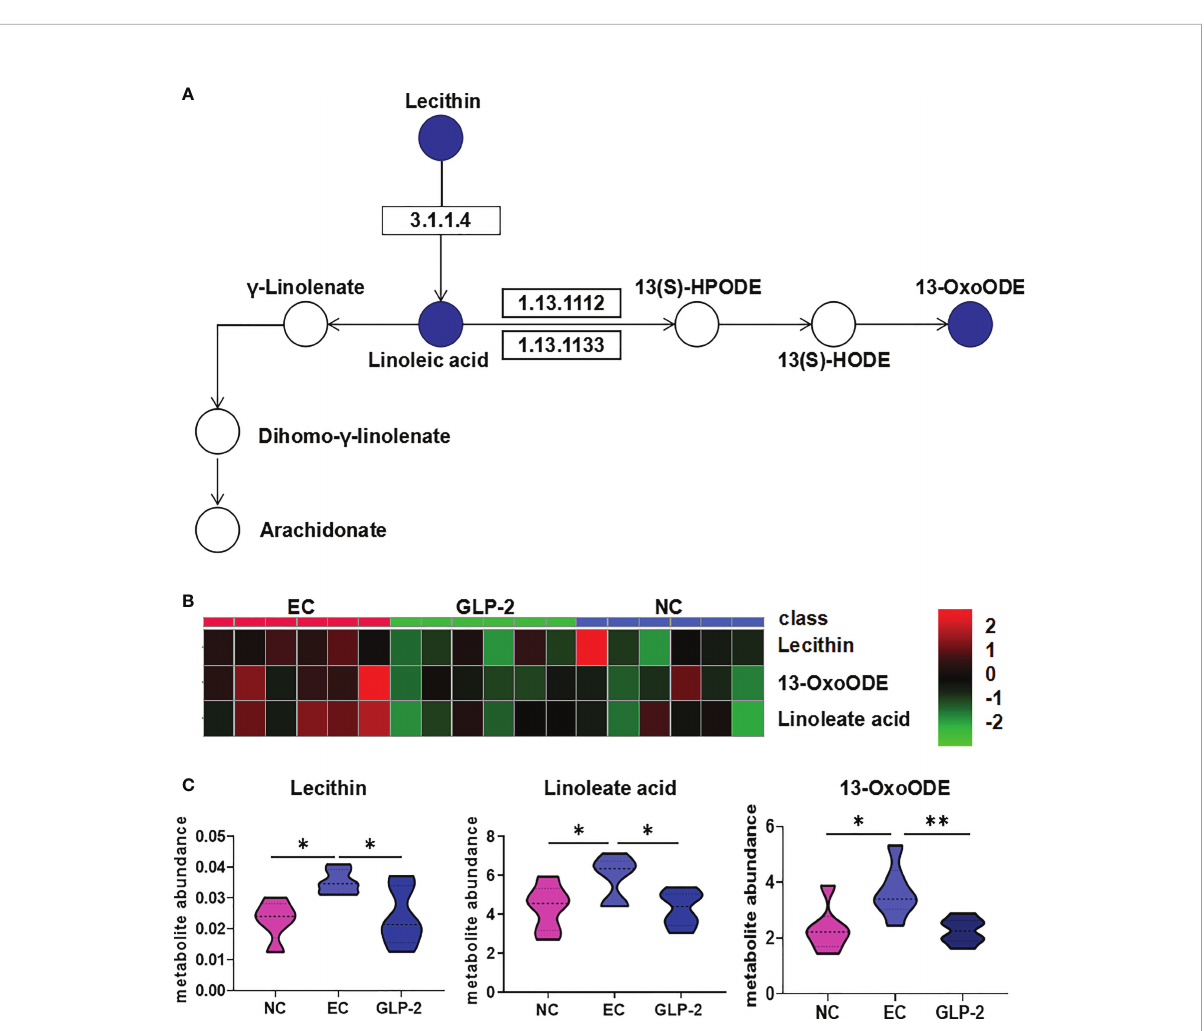
FIGURE 6 Change in linoleic acid metabolism pathway. (A) Differential metabolites of the linoleic acid metabolism pathway in the NC, EC, and GLP-2 groups. The blue circle indicates the differential metabolites. (B, C) the relative abundances of the main metabolites in the linoleic acid metabolism pathway in the NC, EC, and GLP-2 groups based on metabolomic analyses are displayed in the heat map (B) and violin plot (C) . *P < 0.05, **P <